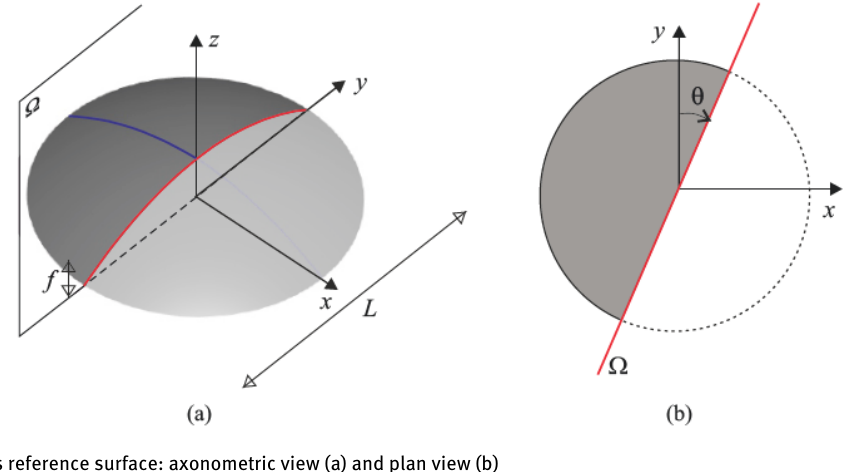
Figure 2: Continuous reference surface: axonometric view (a) and plan view (b)